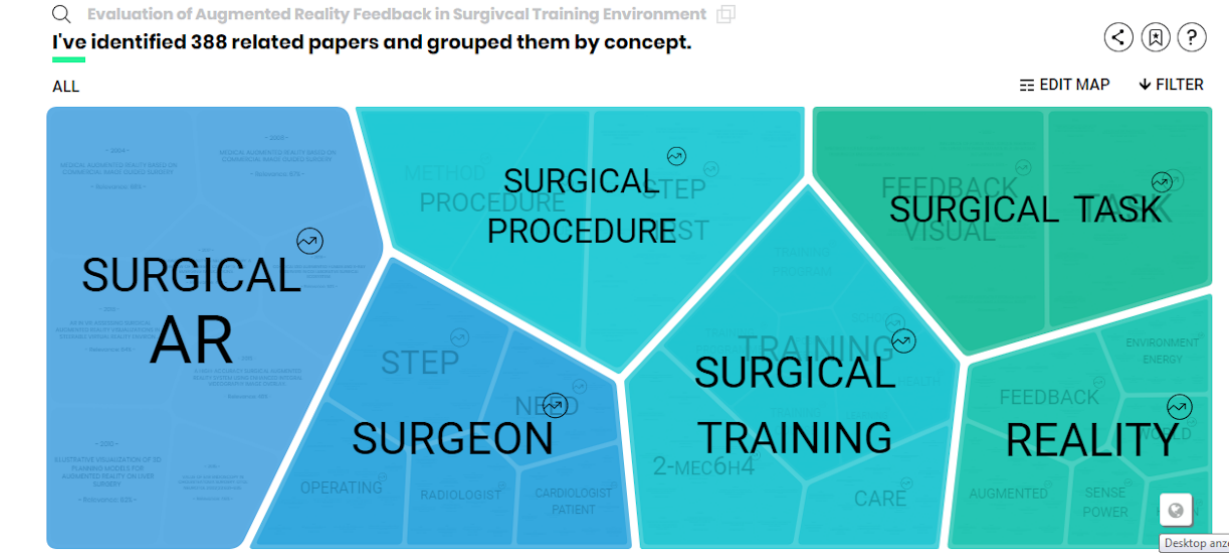
Figure 1. Screenshot of a search result “map” created by the IRIS.AI artificial intelligence research assistant. AR: augmented